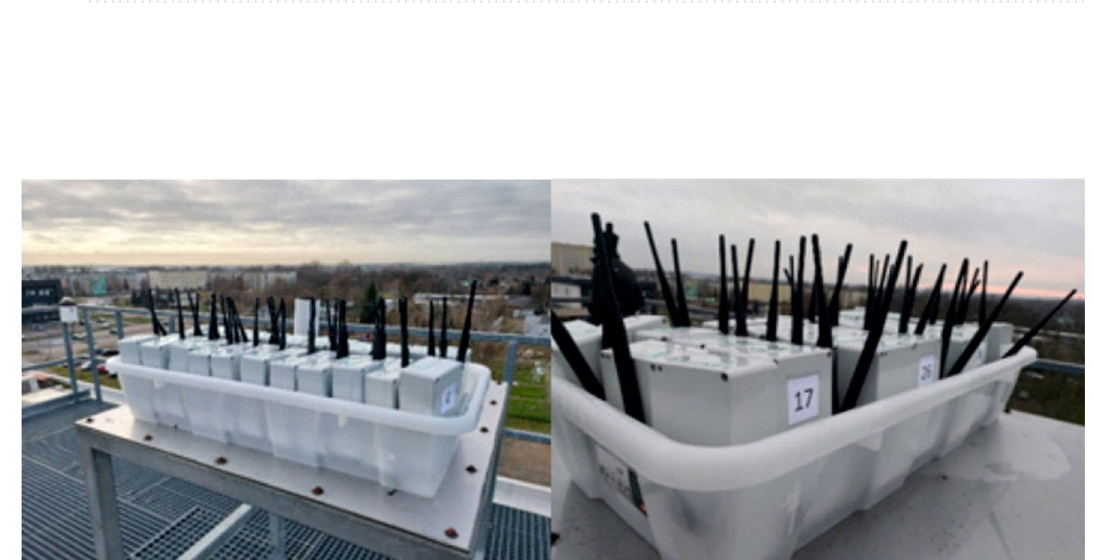
Figure 8. Comparison of measurements from device 1 and 3 with measurements made with the SQM photometer during consecutive nights from November 13 to 18, 2020.